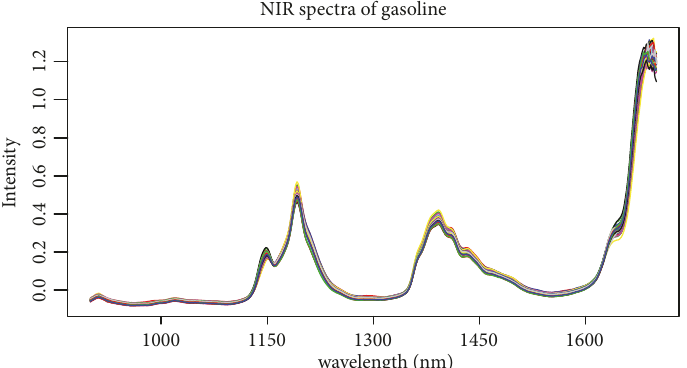
Figure 7: The intensity of each wavelength (predictors) from gasoline data